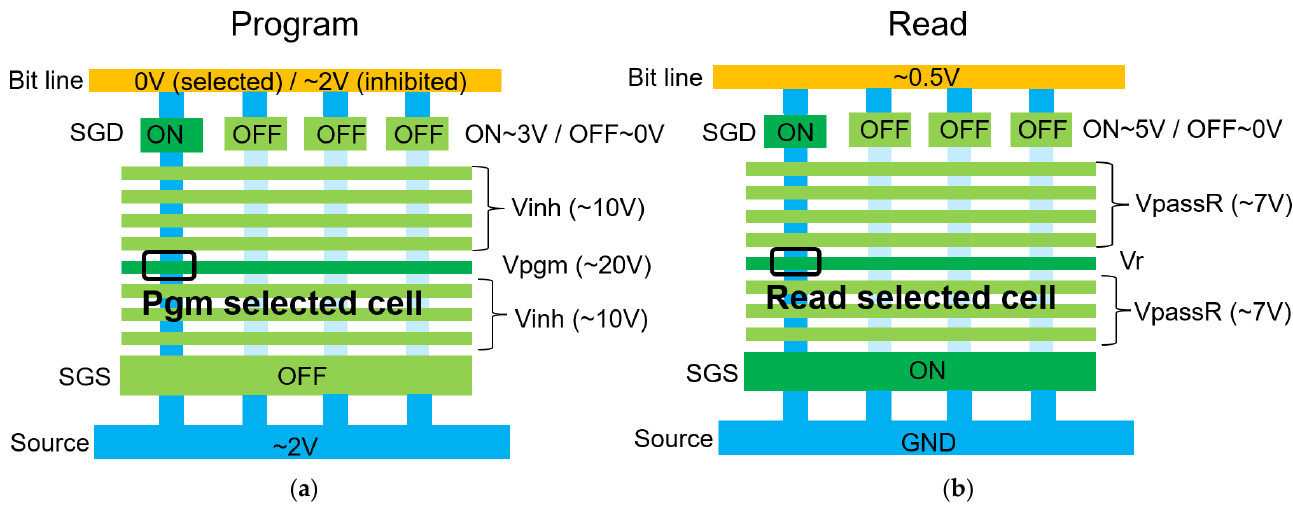
Figure 4. ( a ) Program and ( b ) read operations of 3D NAND. One cell per bit line is selected by selecting one SGD and one WL [35].